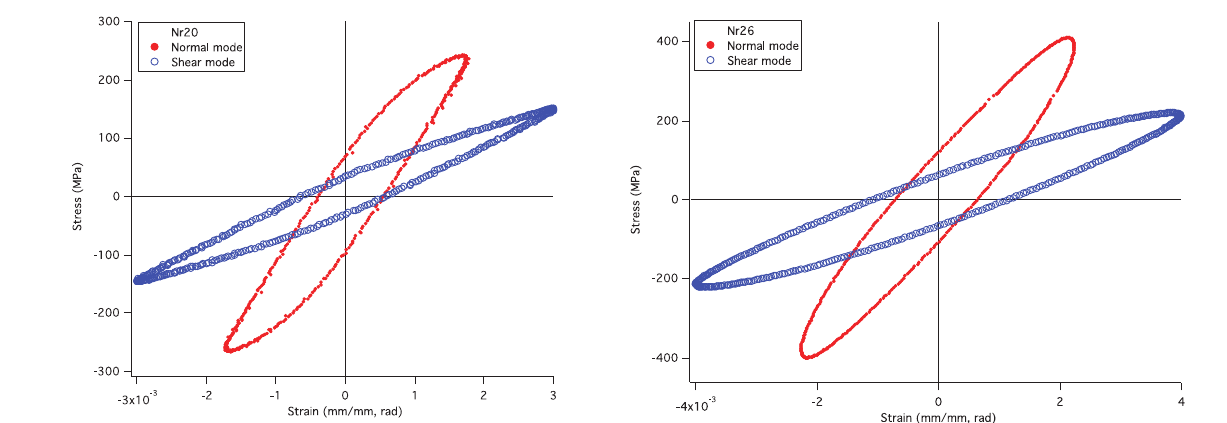
Figure 1: Axial-torsional hysteresis for proportional (Nr20) and nonproportional (Nr26)